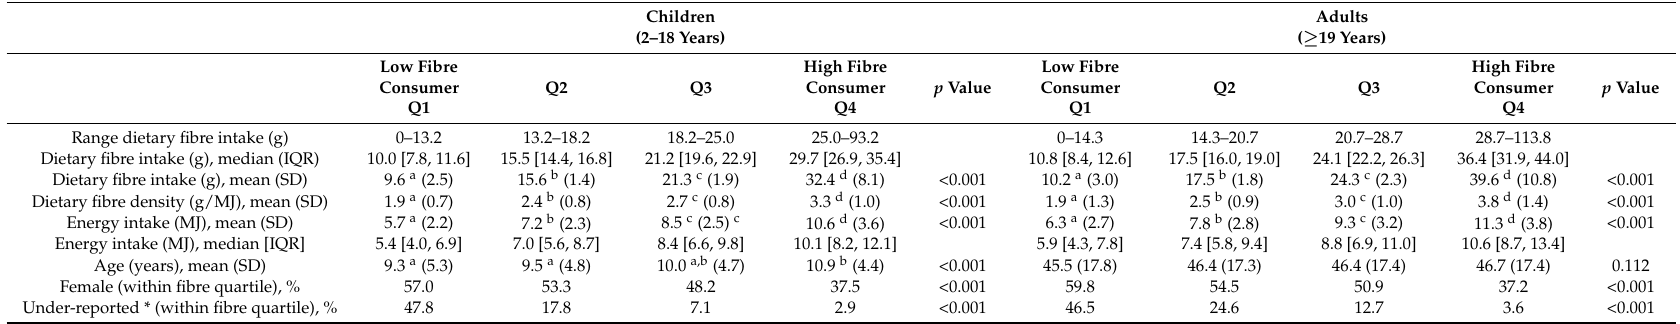
Table 1. Total fibre intake and demographic characteristics by quartiles of dietary fibre